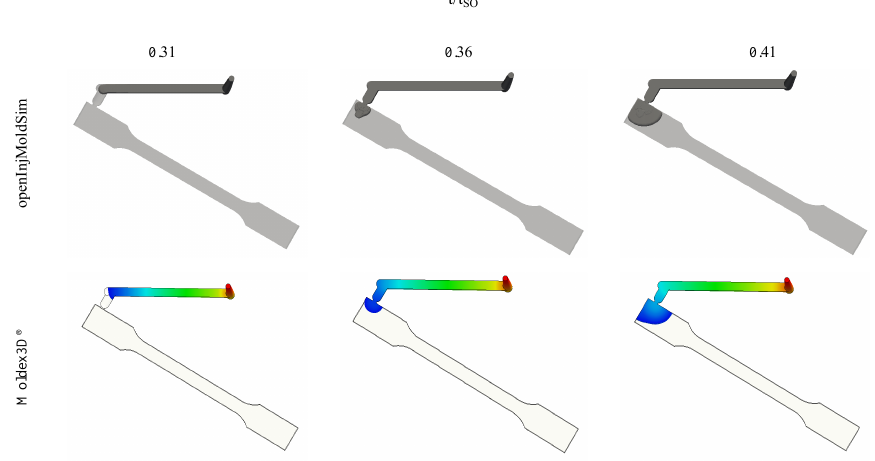
Figure 13. Melt front location for t / t SO = 0.31, 0.36, and 0.41 predicted by both openInjMoldSim and (cid:13) Moldex 3 D R